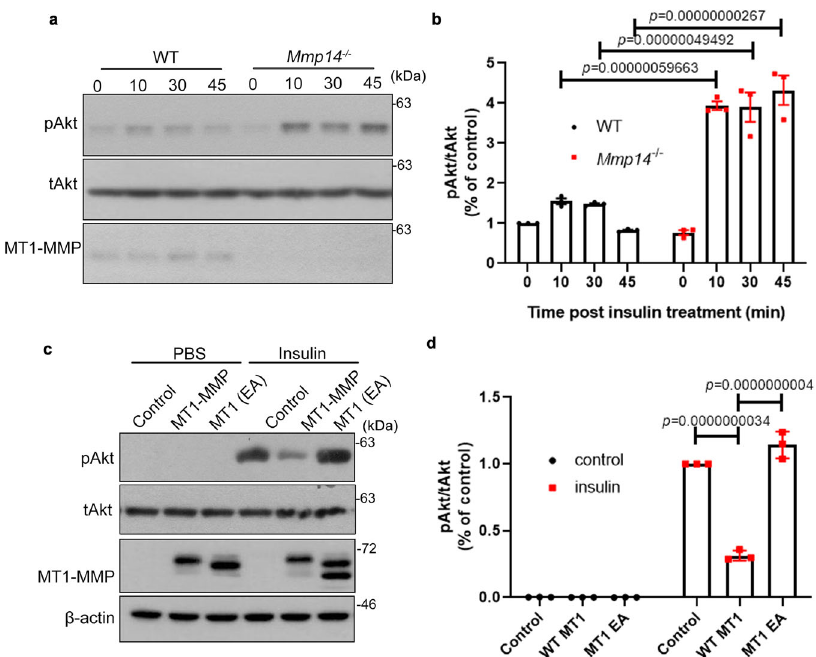
Fig. 3 MT1-MMP suppresses insulin signaling in vitro. a , b Western blotting analyses on the expression of phosphorylated Akt (pAkt) in serum-starved wild-type and Mmp14 − / − primary hepatocytes upon the stimulation of insulin ( a ). Total Akt serves as a loading control. Quanti fi cation of pAkt expression in relative to tAkt expression was shown in ( b ) ( n = 3). c , d HEK293T cells were transfected with either WT or E/A catalytic mutant MT1-MMP (MT1 E240A). The total cell lysates were subjected to western blotting analyses using antibodies indicated. Quanti fi cation of pAkt expression in relative to tAkt expression in 293T cells was shown in ( d ) ( n = 3). Data are reported as average ± s.e.m.; one-way ANOVA ( b , d ). Source data are provided as a Source Data fi